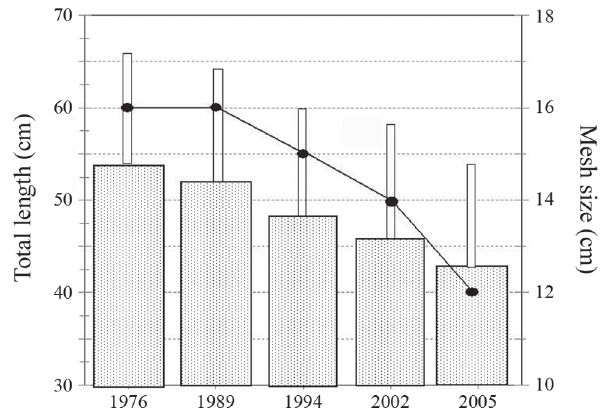
Fig. 4. Variation in the mean length (wide bars), the maximum length (thin bars), and the mesh size (points) between 1976 and